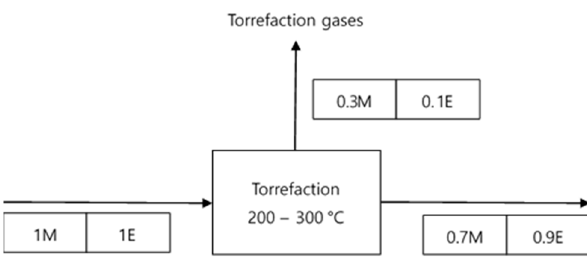
Figure 1. Typical mass and energy balance of the torrefaction process (E: energy unit and M: mass unit).